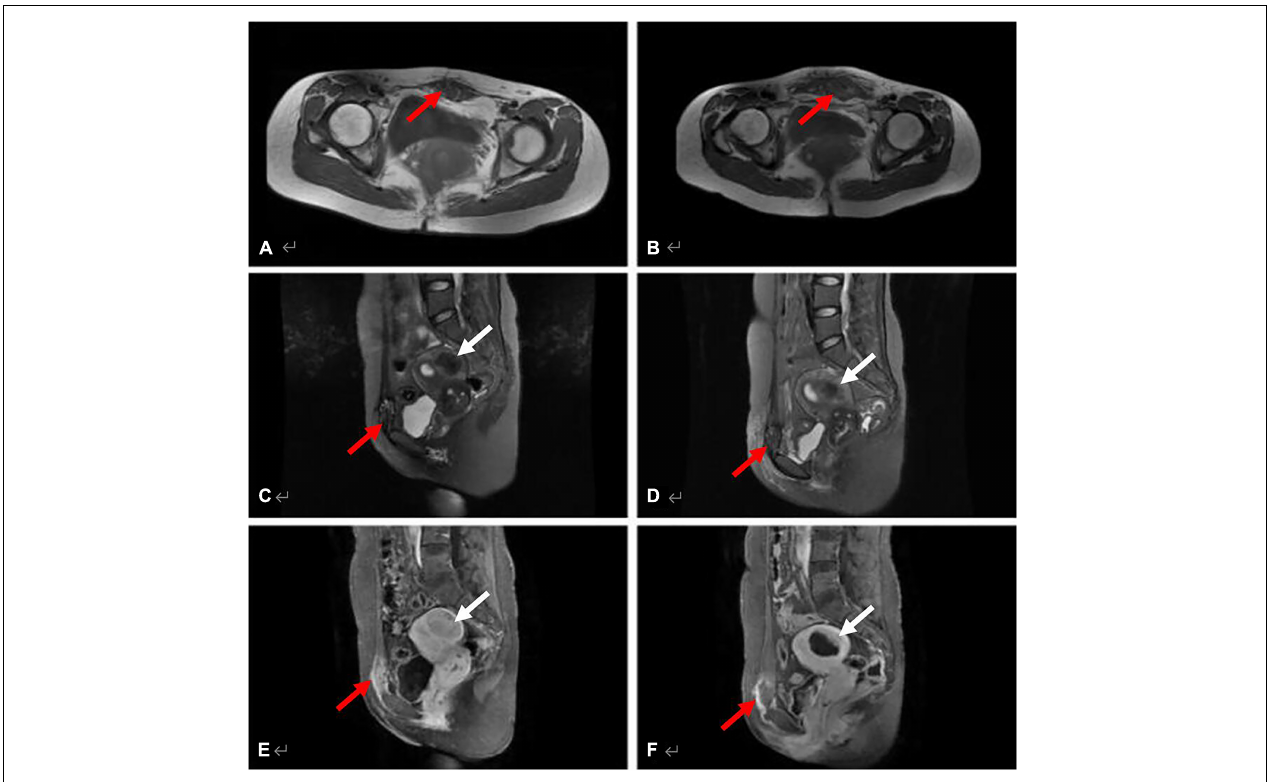
FIGURE 4 | MRI images of AWE in a 42-year-old woman before and after HIFU treatment. The AWE lesion located in the ventral rectus abdominis, invading the rectus sheath. (A) Axial T1WI shows the lesion appeared as mixed signal (red arrow) pre-operatively. (B) Axial T1WI shows the same lesion appeared slightly hyperintense post-HIFU ablation (red arrow). (C,D) Sagittal T2WI with fat-suppression AWE lesion in the rectus abdominis shows high signal (red arrow), and the hysteromyoma in the posterior wall of the uterus appeared hypo-intense as compared with muscle (white arrow). (E) The AWE lesion (red arrow) and the hysteromyoma (white arrow) show evident enhancement and slight enhancement, respectively, on post-contrast T1WI. (F) Both the AWE lesion (red arrow) and the hysteromyoma (white arrow) clearly showed the non-enhancing areas of